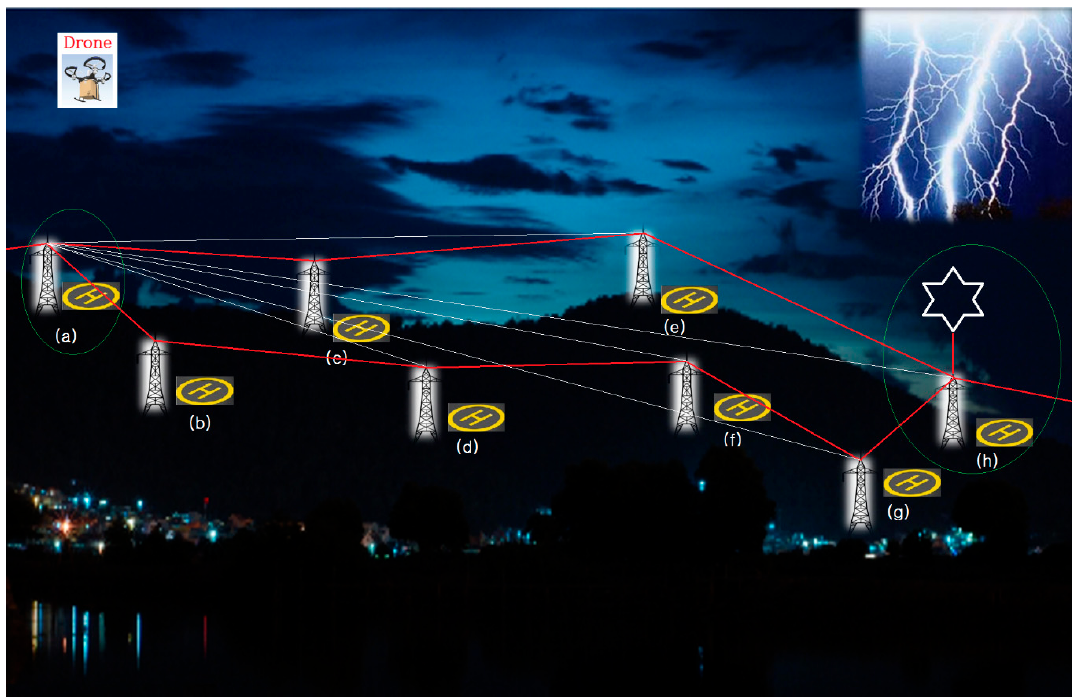
Figure 8. The framework design.